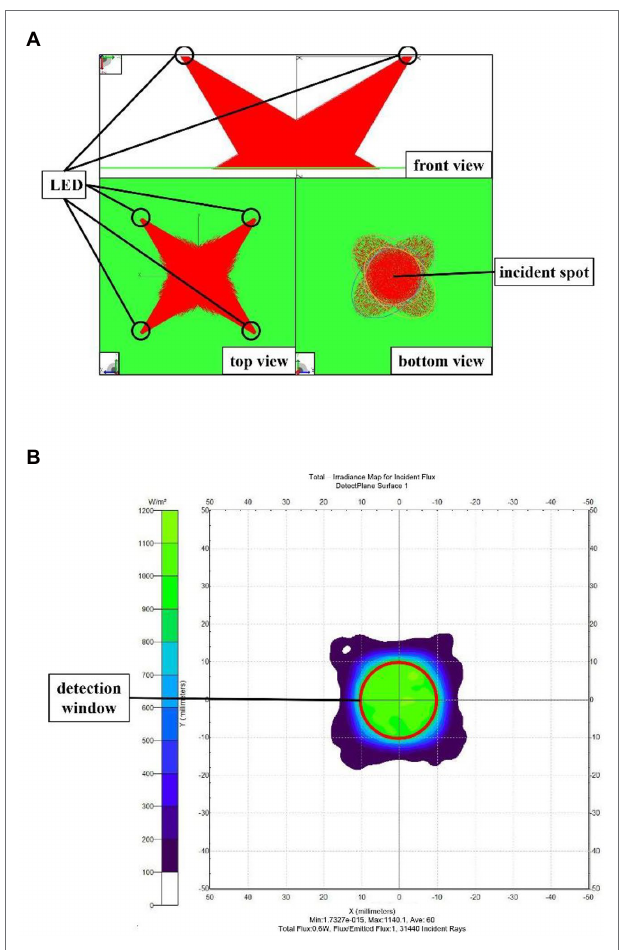
FIGURE 6 | (A) TracePro simulation of the light-emitting unit, (B) Irradiance analysis of the detection